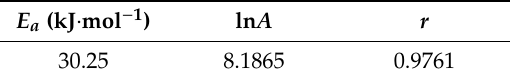
Table 3. Arrhenius plot fitting parameters.